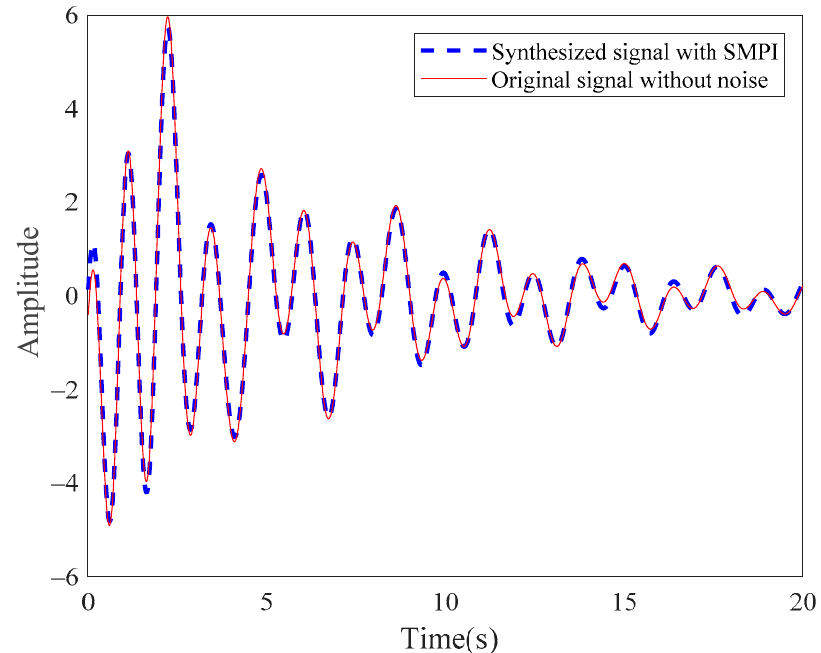
Figure 13. And the comparison of estimated modal parameters of SMPI with true modal parameters is described in Table 9.